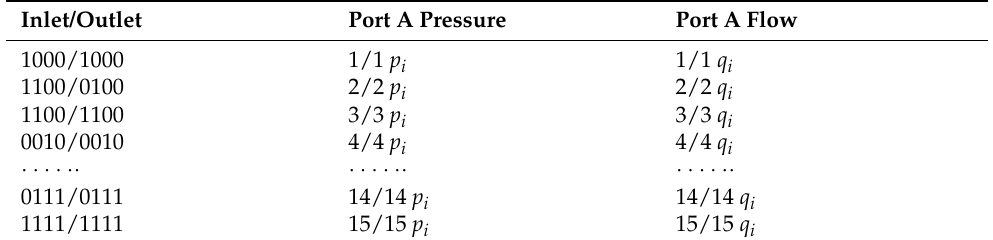
Table 2. Fifteen logic combinations with a pressure transformation ratio of 1.